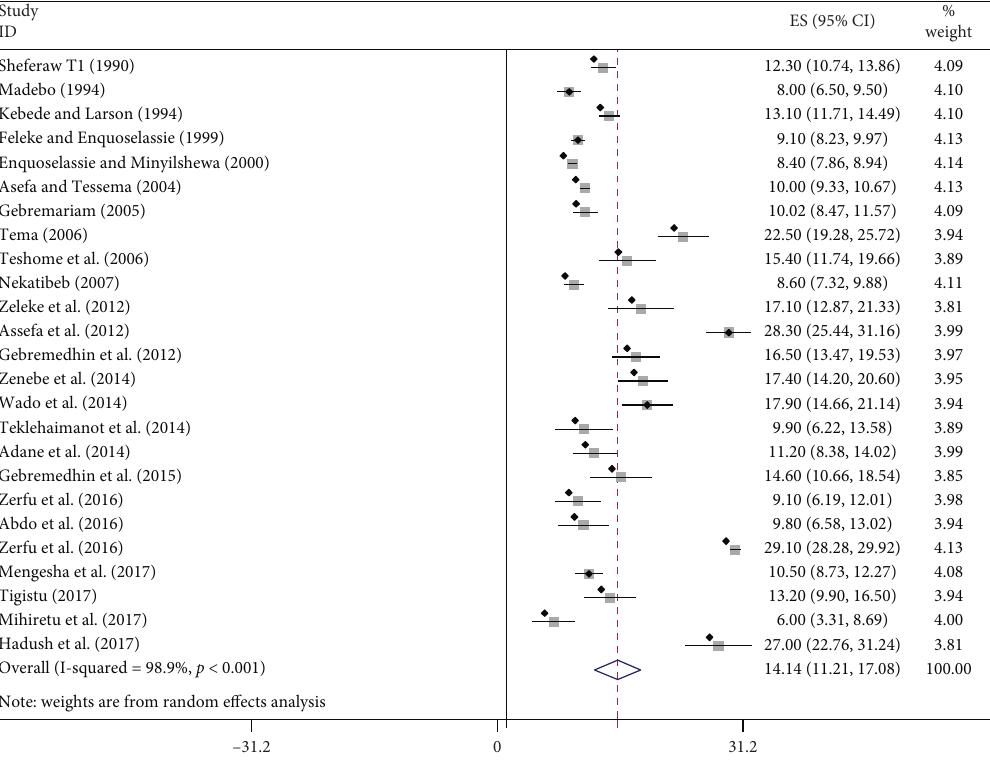
Figure 2: Forest plot displaying the pooled prevalence of low birth weight in Ethiopia.